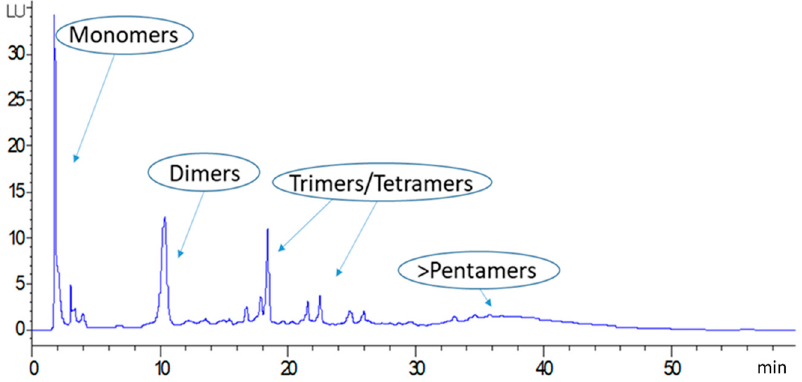
Figure 3. HPLC-FLD chromatogram of larch bark procyanidins. Peaks corresponding to monomers, dimers and higher-grade oligomers are indicated in the Figure.